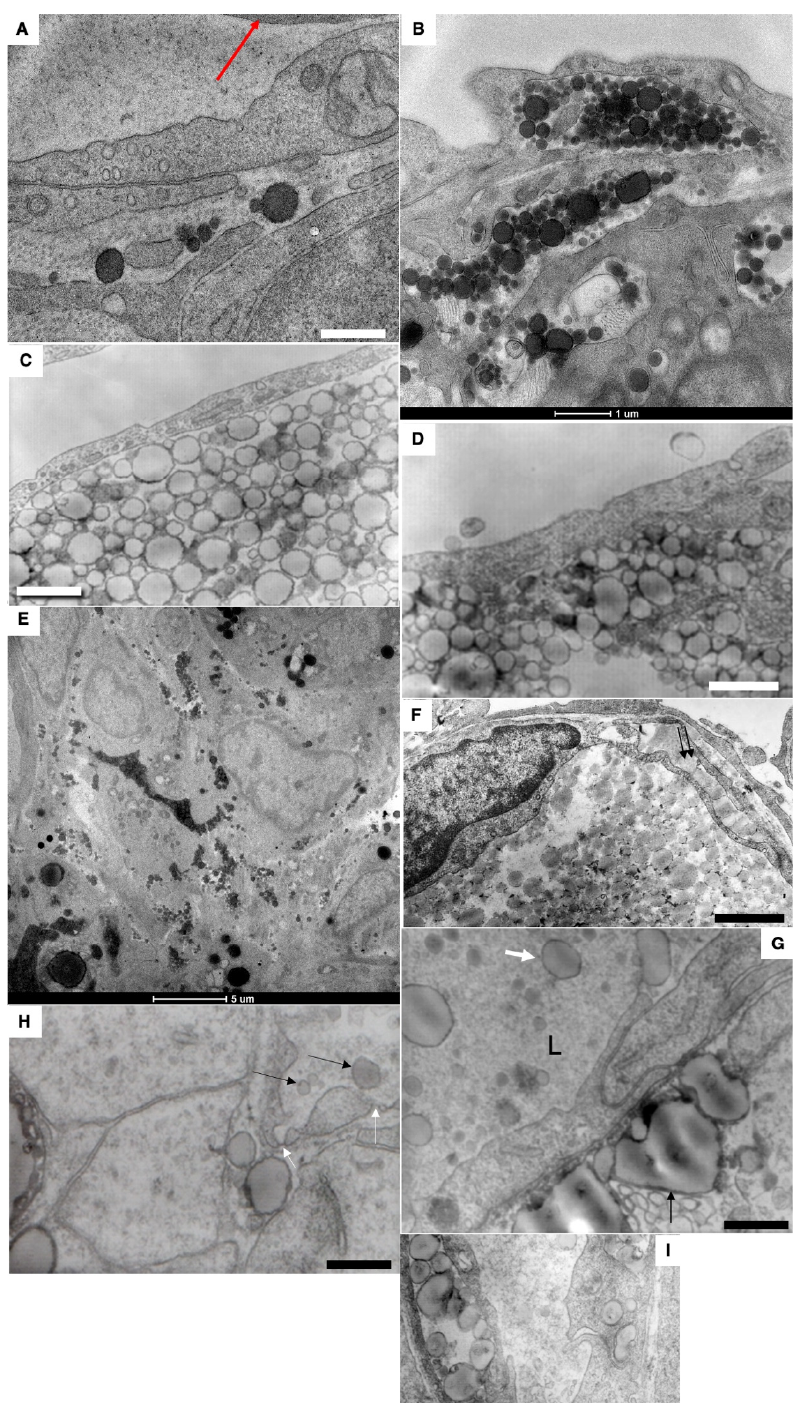
Figure 7. Passage (presumably) of large chylomicrons through intercellular spaces. ( A ) Large chylomicrons are not captured by blood capillaries (the red arrow shows erythrocyte). ( B – D ) Accumulation of chylomicrons in the interstitial space. ( E ). Accumulation of chylomicrons between enterocytes. ( F , G ) Uptake of chylomicrons into the lymphatic capillary. Double arrows in ( F ) show large chylomicron in the inter-endothelial contact. ( G ) Large ChMs in the lumen of the lymphatic capillary. ( H ) Rarely, ChMs (shown by black arrows) were seen in the blood capillary, in the wall of which single fenestrae are visible (shown by white arrows). ( I ) Chylomicrons (to the right) inside the vacuoles within cytoplasm of endothelial cells of lymphatic capillary. Scale bars: 595 nm ( A , H ); 610 nm ( C ): 460 nm ( D , I ); 900 nm ( F ); 570 nm ( G ). In ( B , E ), scale bars are indicated below